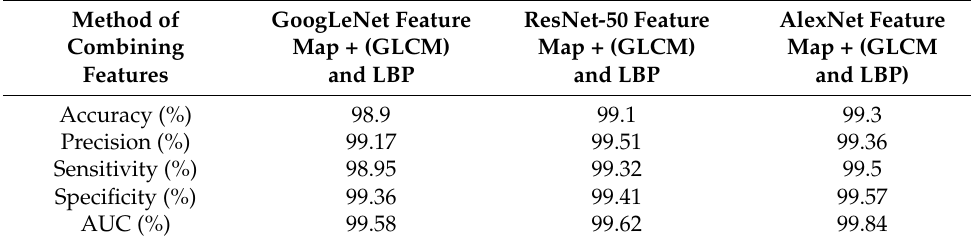
Table 6. Performance of ANN through hybrid features for early detection of hemorrhages. Method